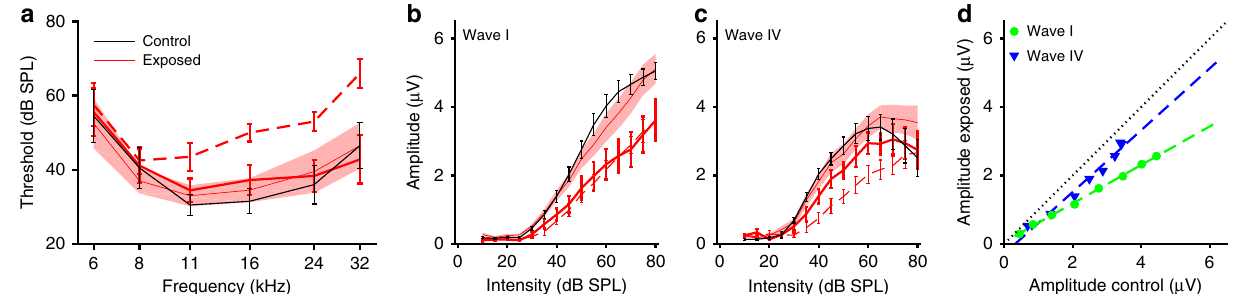
Fig. 1 Noise-induced hidden hearing loss. ABR measurements show temporary hearing threshold loss, but permanent reduction of ABR wave I. a Tone-pip ABR thresholds of the left ears before (thin red line, red shaded area denotes ±s.e.m.) and 1 day (dashed red line) and 4 weeks (solid red line) after exposure to octave-band noise at 100 dB SPL ( n = 10). Black line — thresholds of control animals ( n = 8) 4 weeks after sham exposure. All error bars denote ±s.e.m. b Growth functions of ABR wave I amplitude for 50 µ s clicks, colour scheme and animal numbers as in a . c Growth functions of ABR wave IV amplitude for 50 µ s clicks, colour scheme and animal numbers as in a . d Plot of click-evoked ABR wave amplitudes (4 weeks after) of exposed vs.